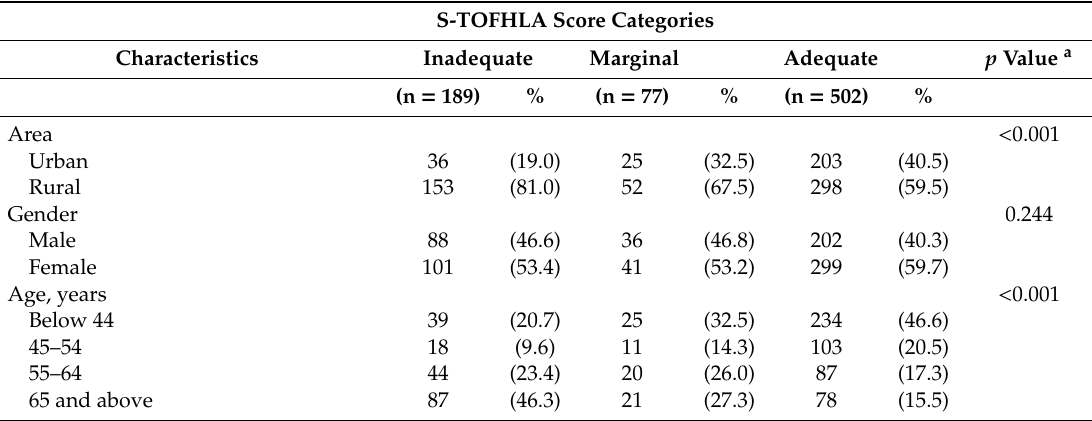
Table 2. Distribution of respondents by health literacy